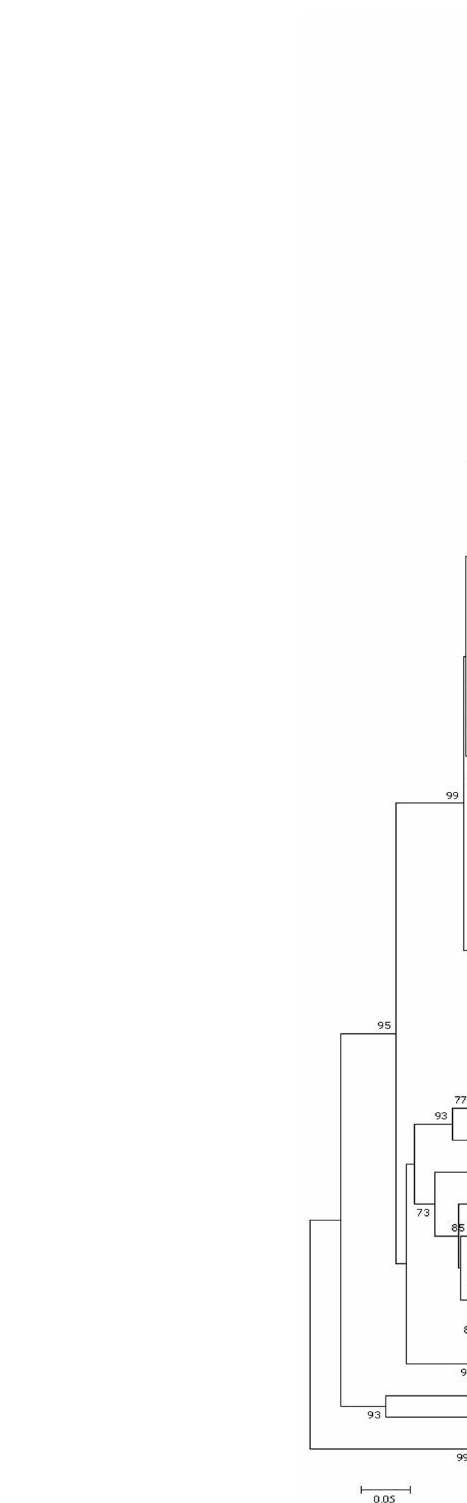
Frontiers in Medicine |